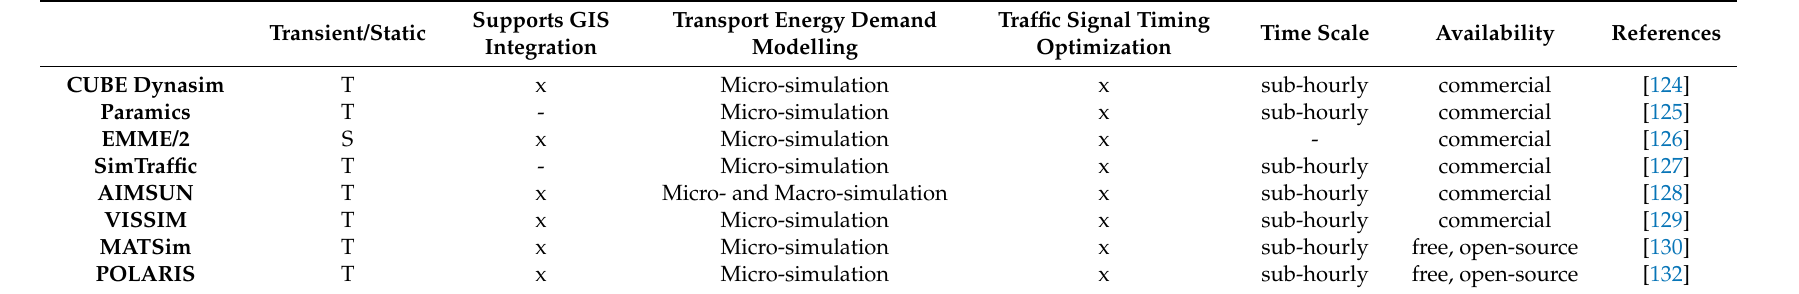
Table 3. Characteristics of reviewed simulation tools for transport energy demand